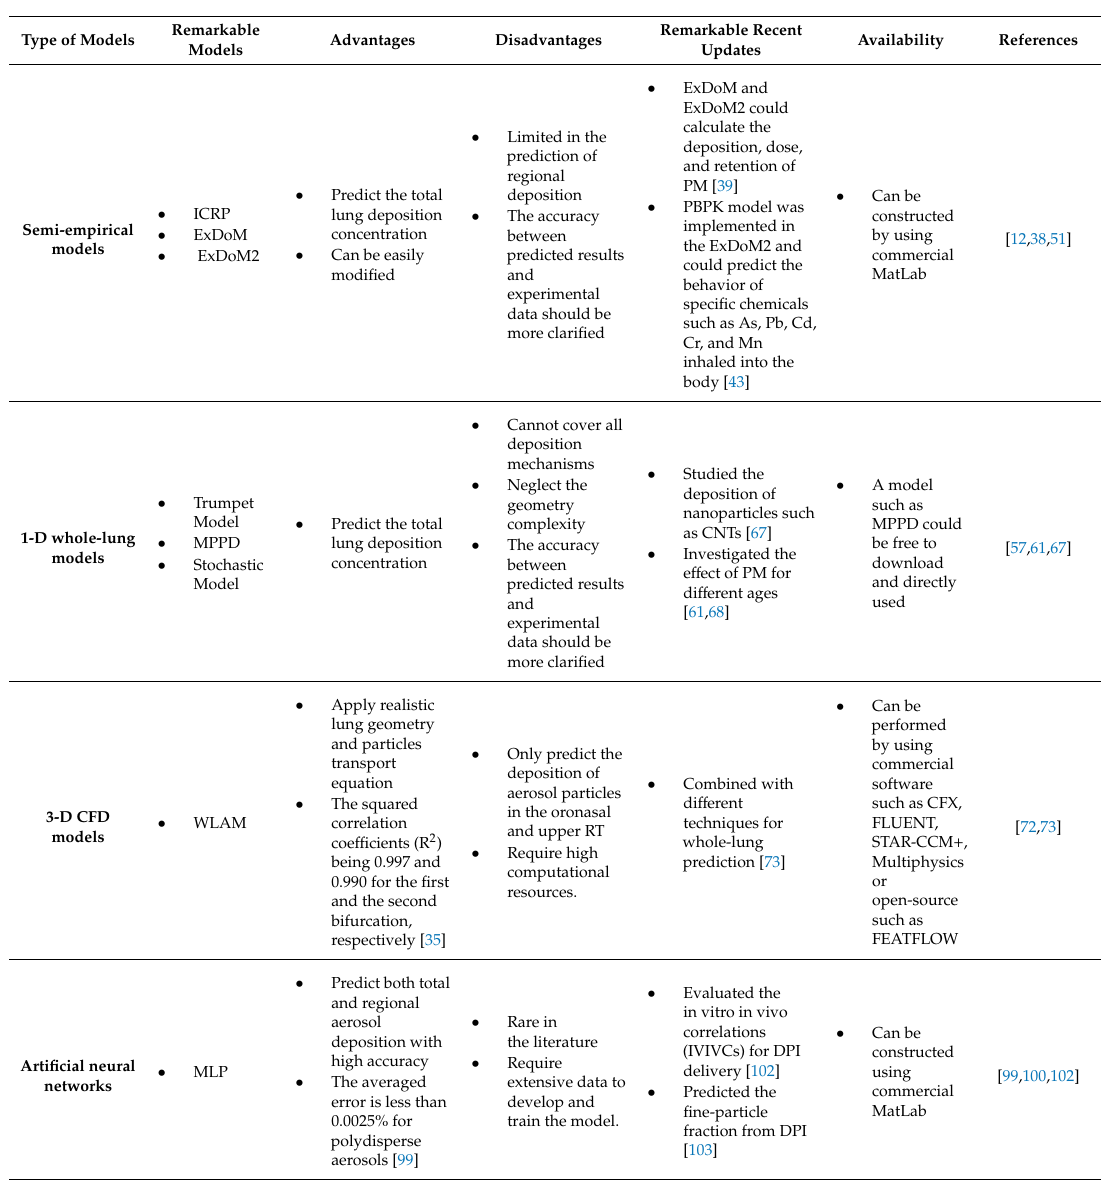
Table 2. Advantages and disadvantages of di ff erent computational models for prediction of aerosol in the human respiratory